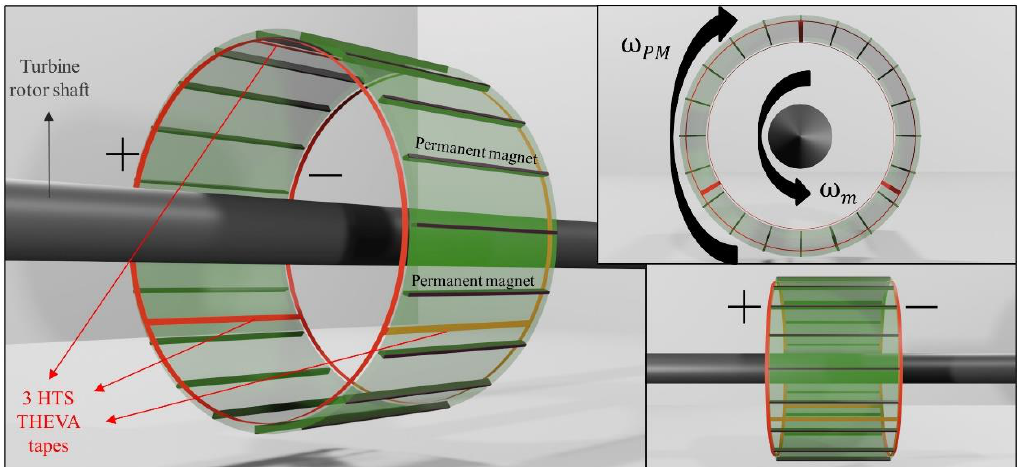
Figure 4. The 3D scheme of the dynamo flux pump. ω m is the rated rotating speed of the turbine and thus refers to both the rotor shaft and the 3 HTS tapes. + and − indicate the superconducting terminals to which the field winding is connected. The HTS tapes are fixed with respect to the HTS field winding and move with the generator’s rotor.